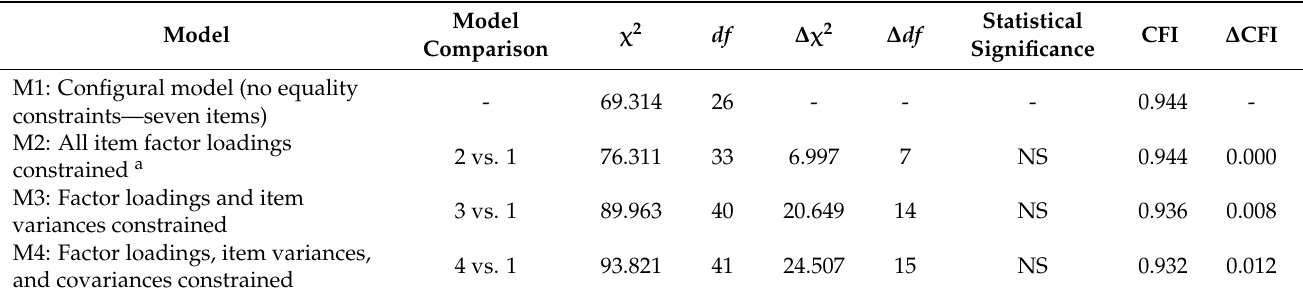
Table 7. Summary of fit statistics for tests of gender